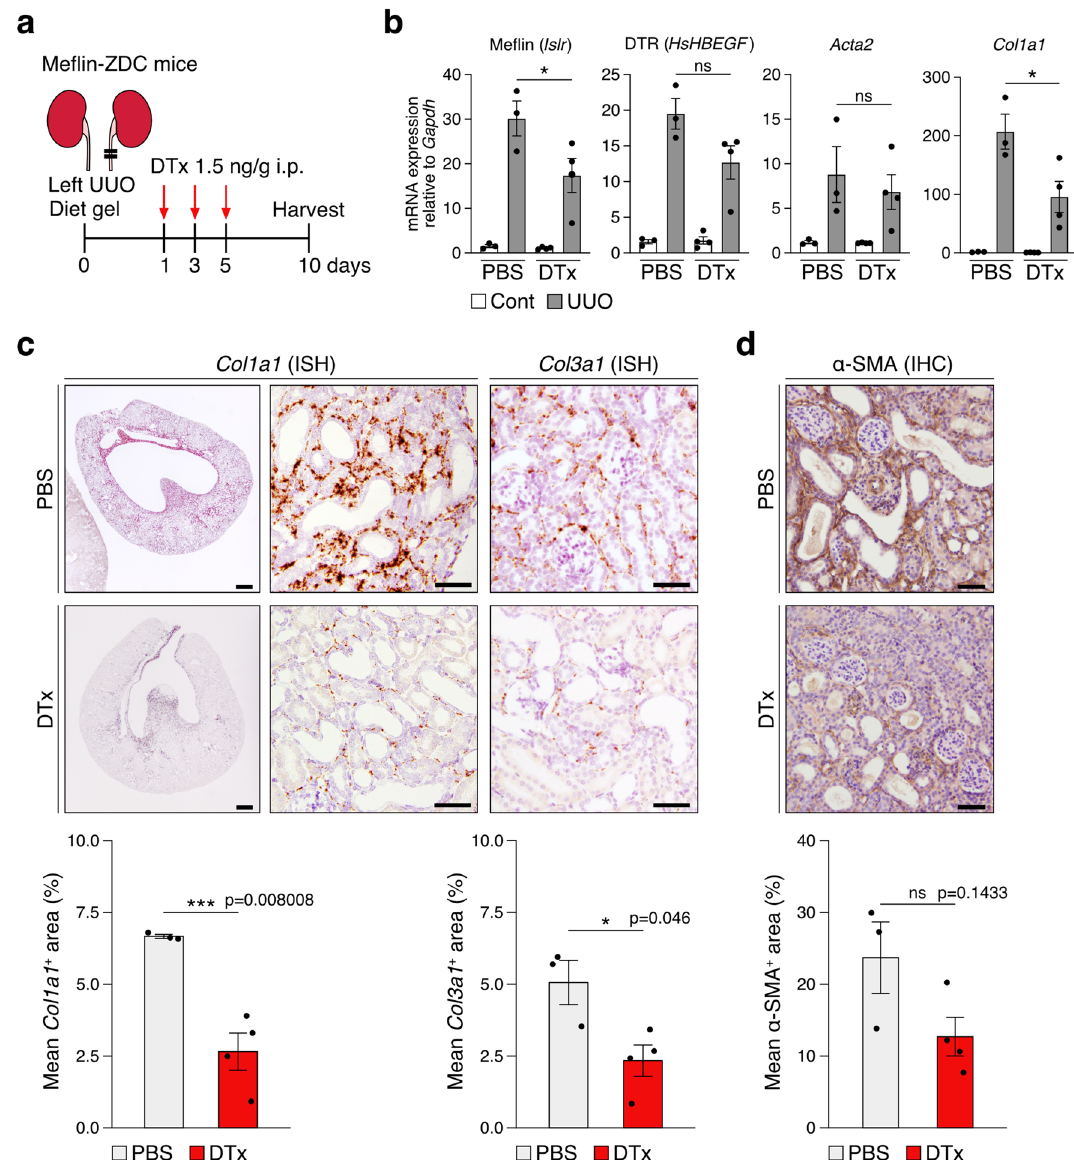
Figure 8. Effect of genetic ablation of Meflin + PMCs on collagen production and fibrosis in the UUO